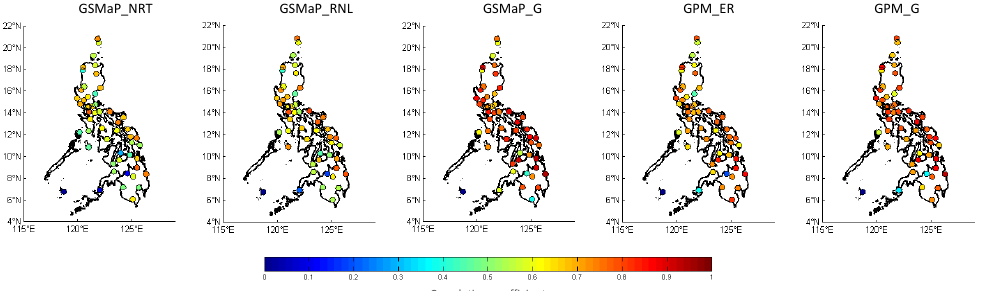
Correlation coefficient Figure 4. Plot of temporal correlation coefficient per station of observed and satellite TC rainfall for all selected TCs from